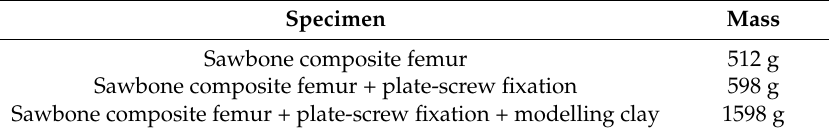
Table 1. Mass of composite femur specimen with plate-screw fixation.